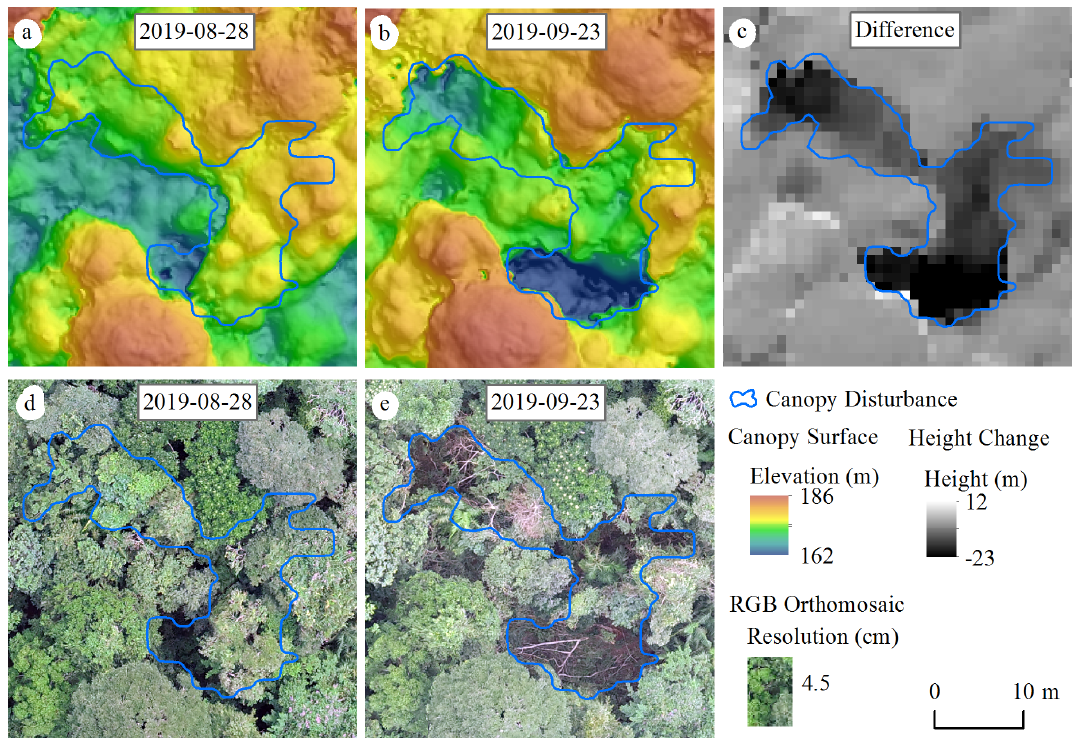
Figure 1. Canopy disturbance visualized on canopy surface models and orthomosaics calculated from photogrammetric analyses of drone imagery. (a, b) Elevation models for a portion of the study area on two successive dates, 28 August (a) and 23 September 2019 (b) . (c) Dif- ference in elevation between the two dates, with the black area indicating a large decrease in canopy elevation. (d, e) RGB orthomosaics of the same dates. Please note that the date format in this figure is